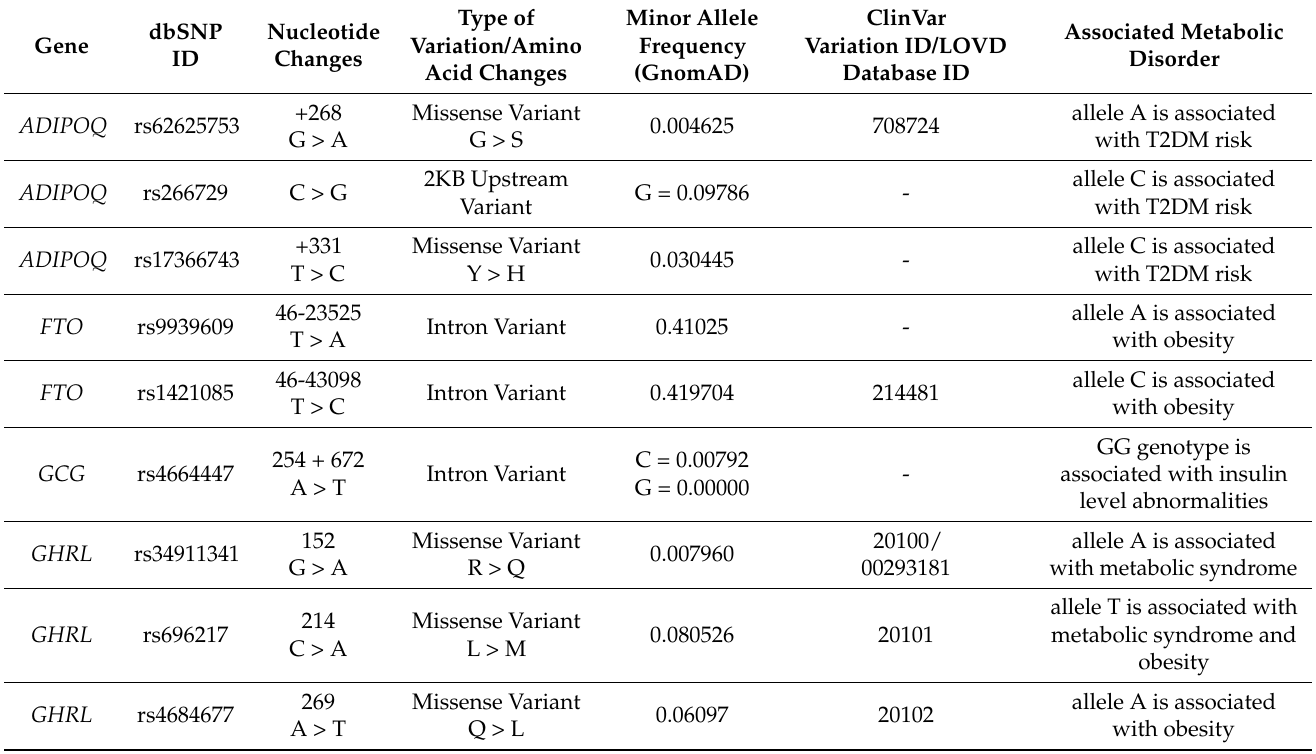
Table 2. Single-nucleotide variants associated with metabolic